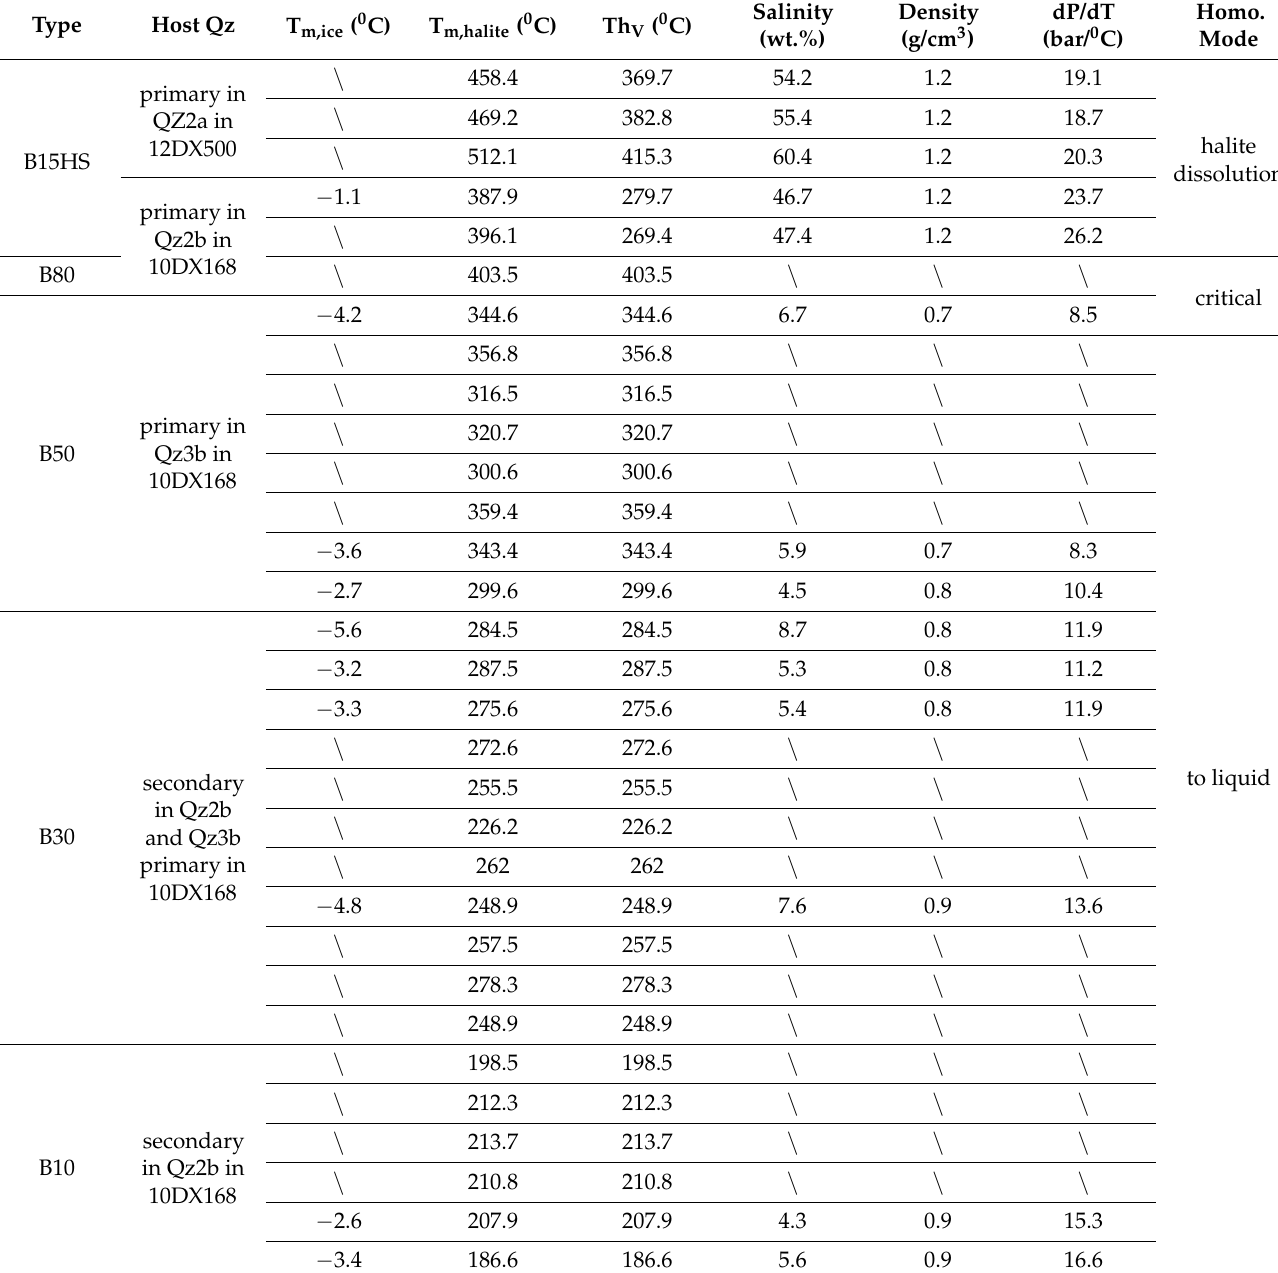
Table 3. Fluid inclusion microthermometry of the Tongchang porphyry Cu